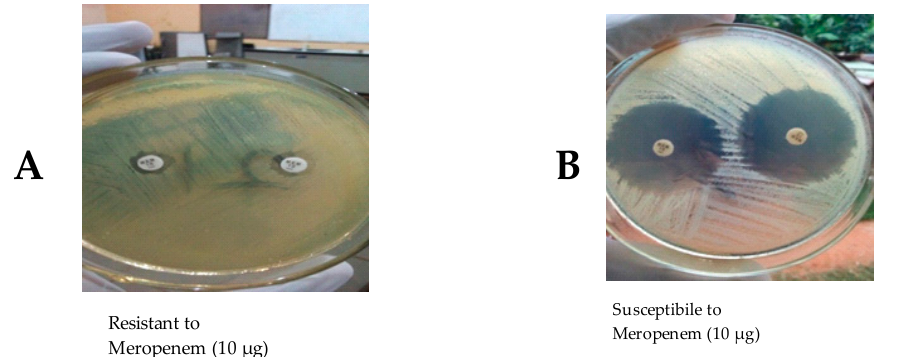
Figure 2. Antibiotic Susceptibility testing for the Detection of Carbapenem resistance. Table 4. Carbapenem susceptibility of the Enterobacteriaceae Isolated.